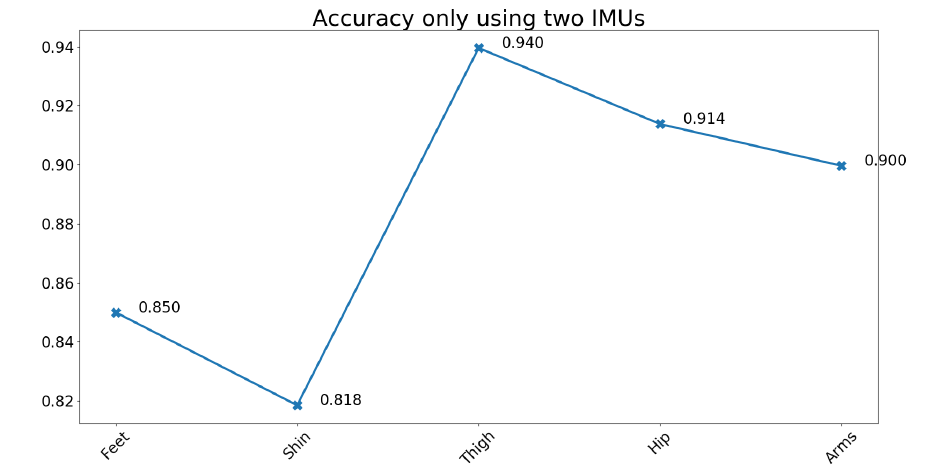
Figure 10. Accuracy of the classifier network reached by one pair of IMUs at different sensor locations, being trained individually. Training was again done with 10 subjects and tested on 1 unseen